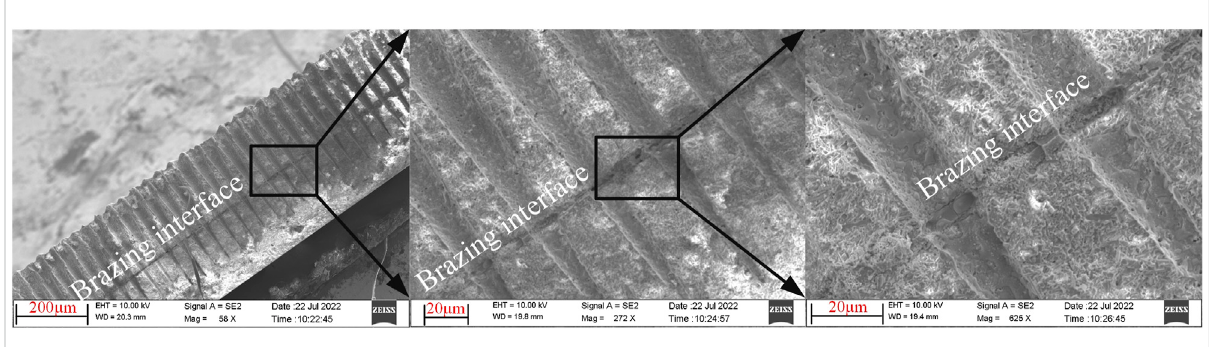
FIGURE 6 SEM images of the cross section of the brazed interface at different magni fi cations.